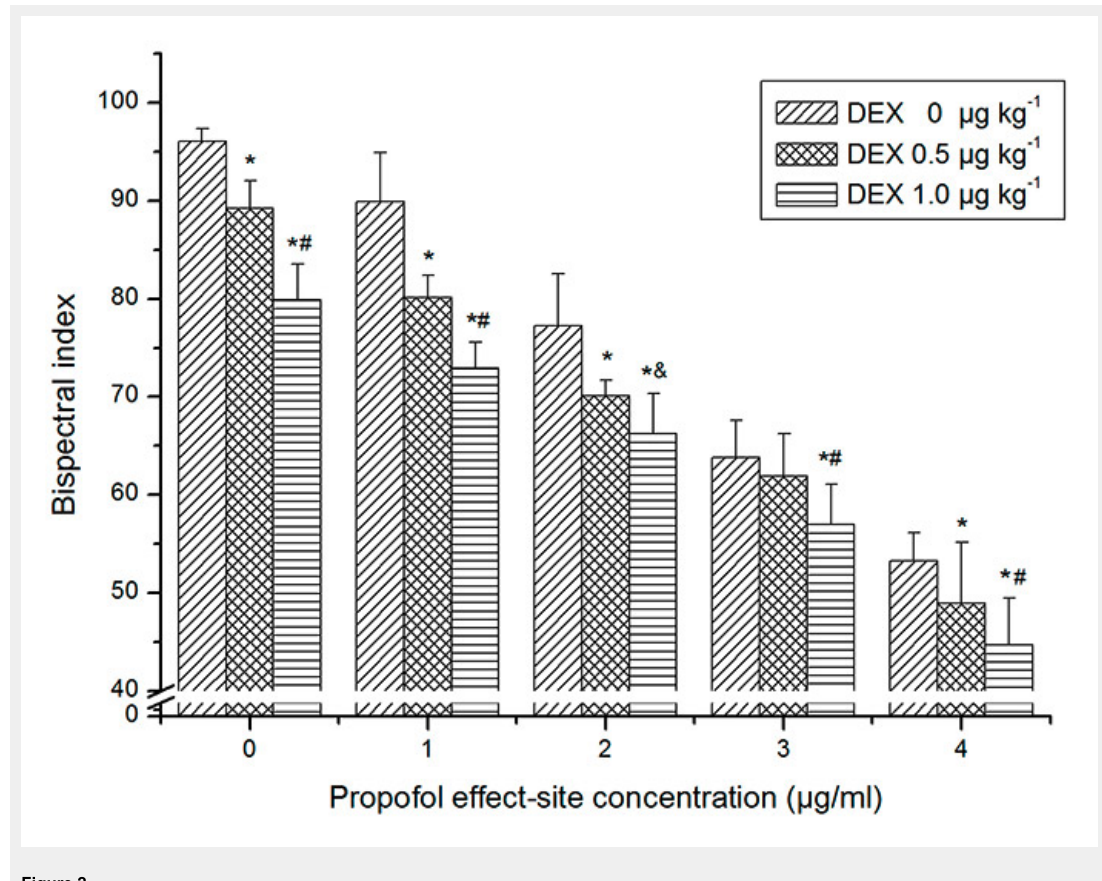
Figure 2 The effects of dexmedetomedine on bispectral index at every propofol effect-site concentration. Bars represent mean ± SD. * Significant differences compared with control group at the same propofol effect-site concentration (p<0.01). # Significant differences between dexmedetomidine (DEX) 0.5 and 1.0 μg kg –1 (p<0.01). ＆ Significant differences between dexmedetomidine 0.5 and 1.0 μg kg –1